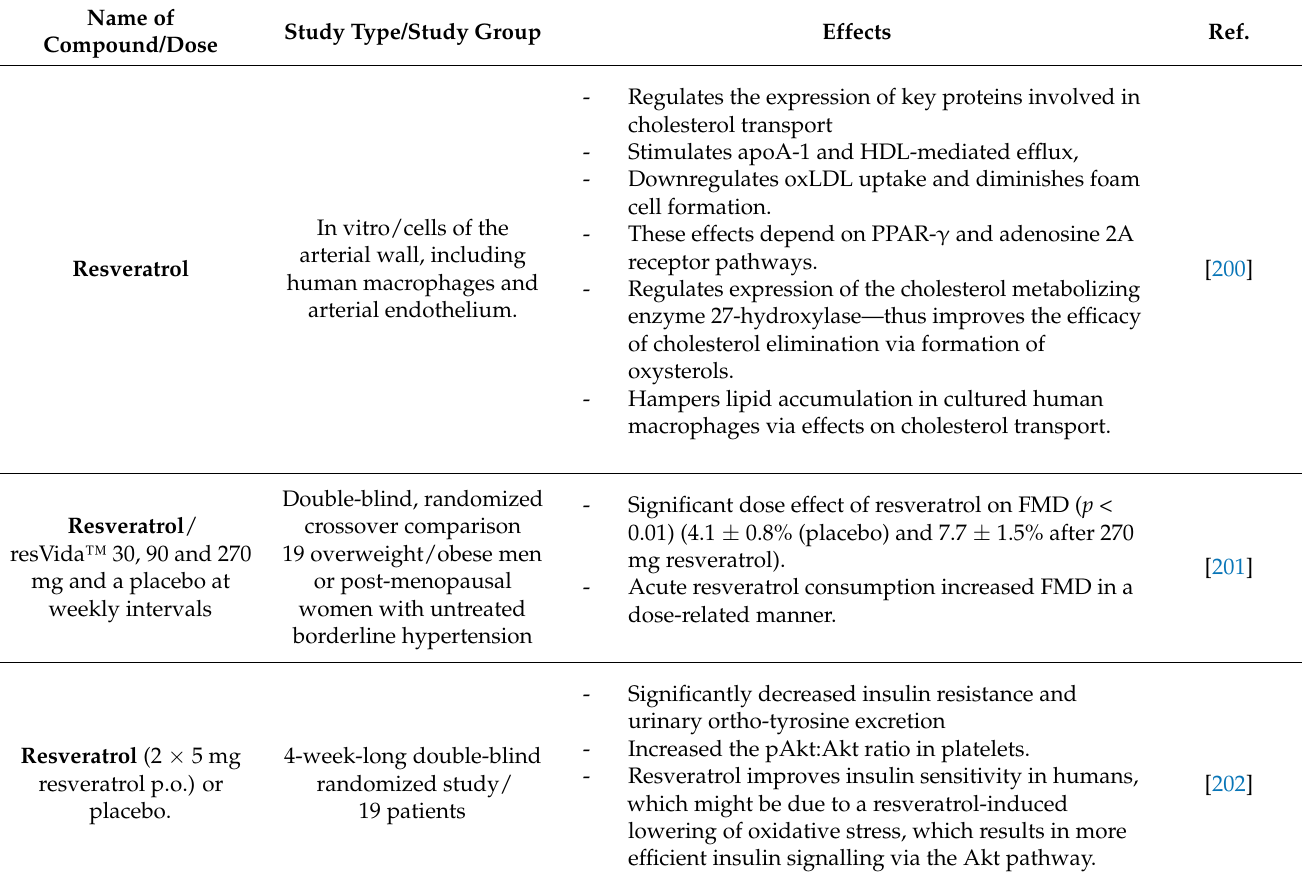
Table 1. The results of studies regarding the impact of natural compound on cardiovascular